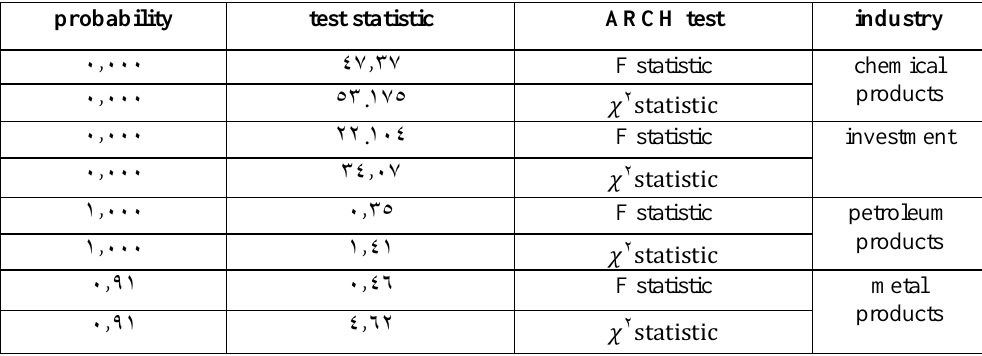
Table 3. Conditional heteroscedasticity test